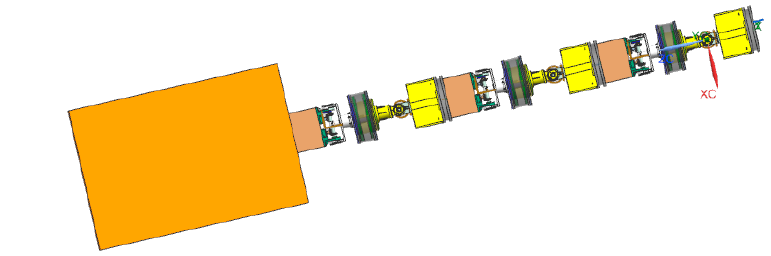
Figure 4. The space manipulator structure model. Table 1. VSJ system parameters.